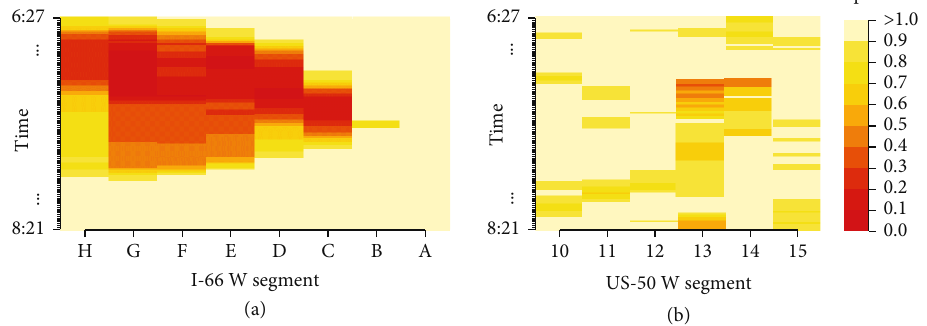
Figure 11: Speed ratio matrices f (a) I-66W and (b) US-50 W for a collision occurred in segment H of I-66W at 9/4/2019 6